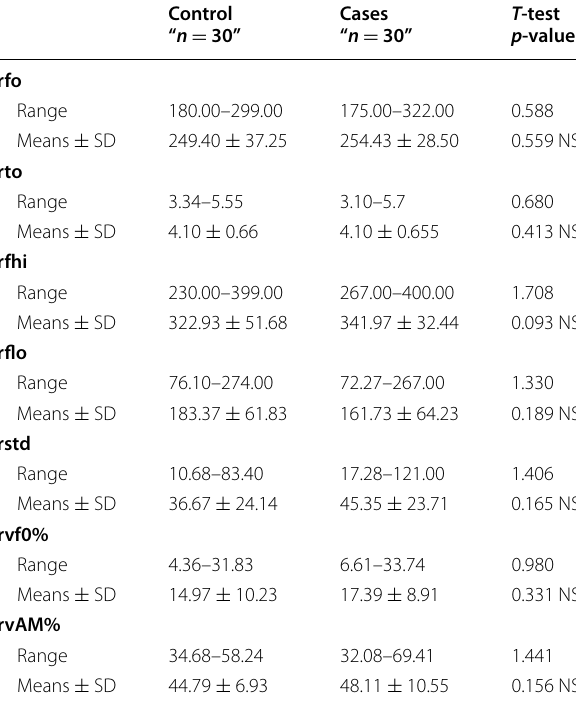
Table 1 Comparison between the two groups regarding real- Table 2 Comparison between the two groups regarding intonation stimulability